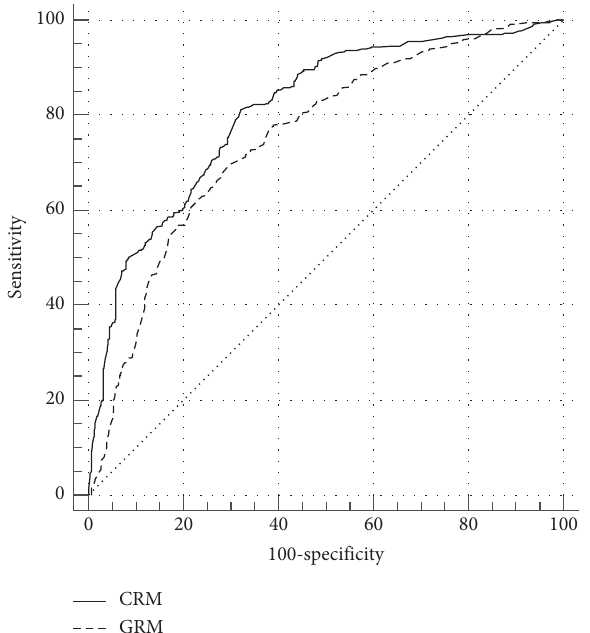
Figure 2: Comparison of 2 models by receiver operating characteristic curves. GRM: GRACE risk model; CRM: CAMI-NSTEMI risk model.